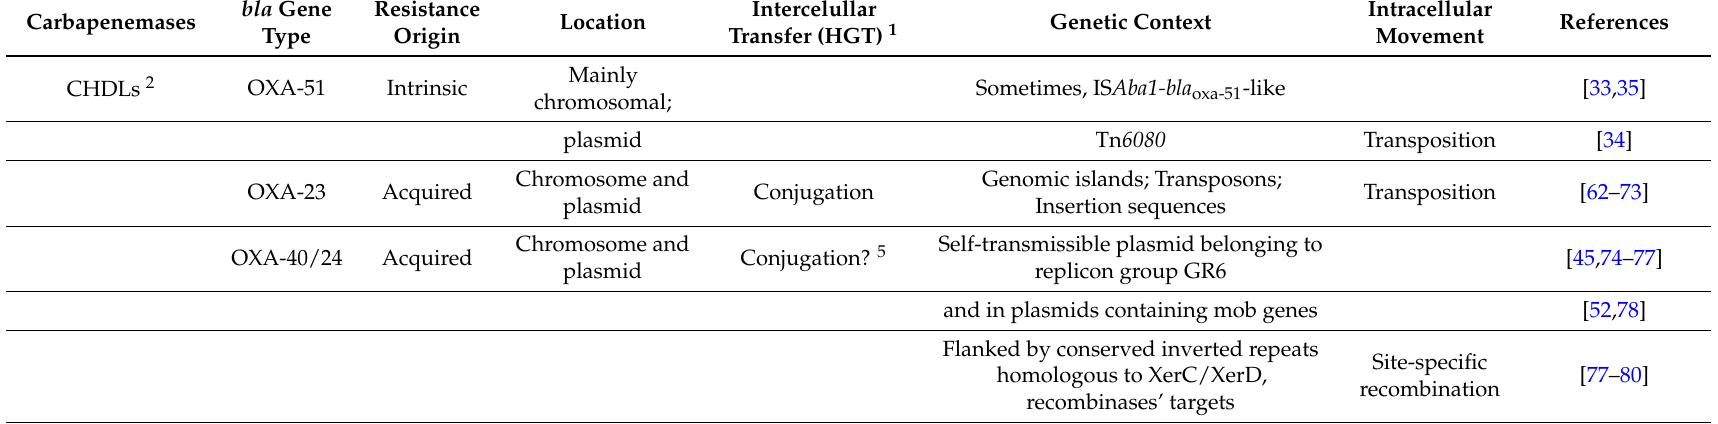
Table 1. Carbapenemase Genes in Acinetobacter baumannii : Genetic Location, Horizontal Gene Transfer Mechanisms, Genetic Context and Movement of Mobile Genetic.